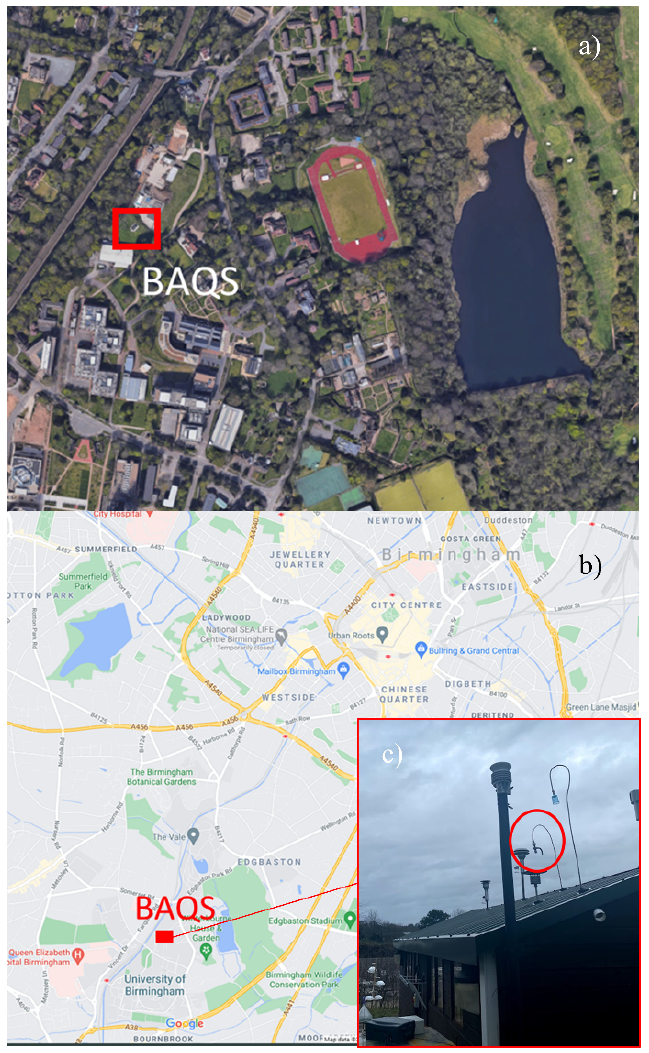
Figure 1. ( a ) Location of the Birmingham Air Quality Supersite (BAQS) (aerial view), ( b ) location of BAQS in relation to Birmingham, UK, and ( c ) sampling inlet used for low-cost sensors. Sampling took place from 24 January 2020 to 12 March 2020, prior to any COVID-19 restrictions. During this time, temperatures ranged from − 2 to 8 ◦ C with relative humidity ranging from 60–100%. Wind direction and speed was variable throughout the